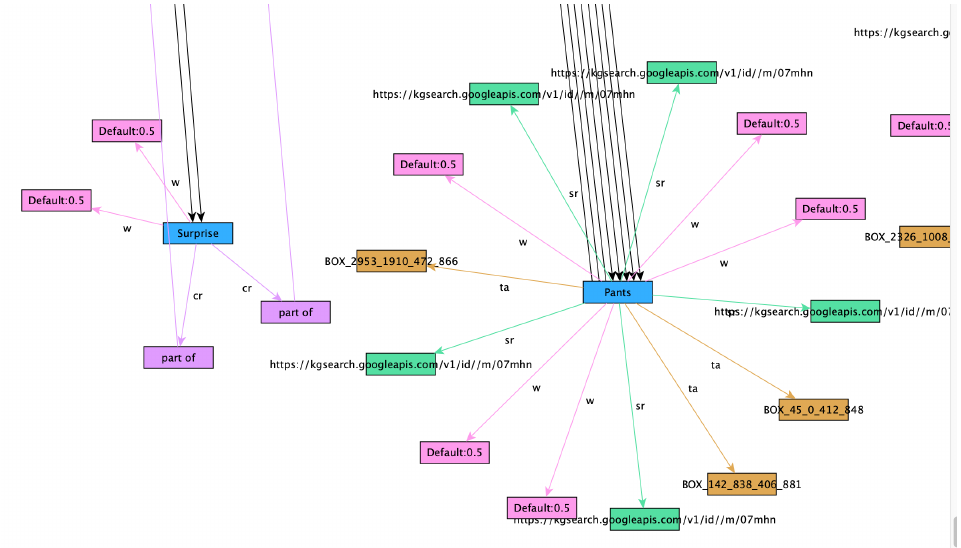
Figure 12. GraphML export of MMFVG constructed from the sample